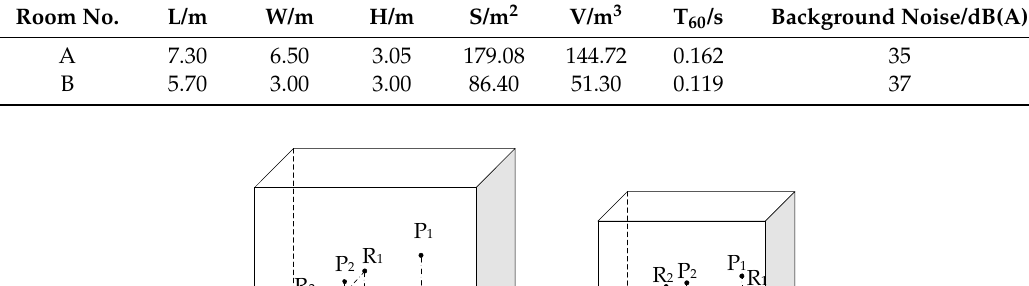
Figure 2. Sketch map of positions of sound source and receiving point in real rooms. ( a ) Room A ( b ) Room B .